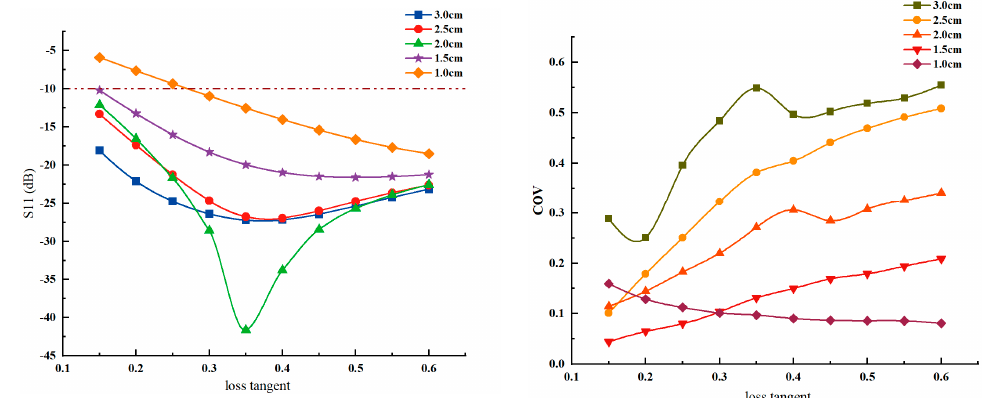
Figure 10. Effect of loss tangent on microwave efficiency and temperature uniformity (reflectance coefficients for different water heights are depicted on the left and COV for different water heights on the right).